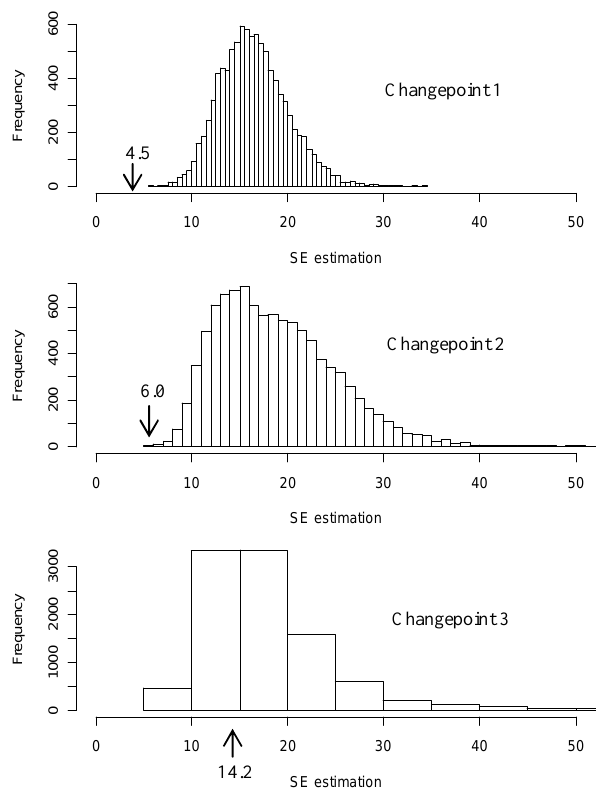
Figure B. Distributions of estimated SE for the three change points. The bootstrap means of the changepoints were 111, 178, 240msec for change points 1, 2, and 3, respectively. Based on the 10,000 bootstrap samples, the corresponding SEs were 4.5, 6.0, and